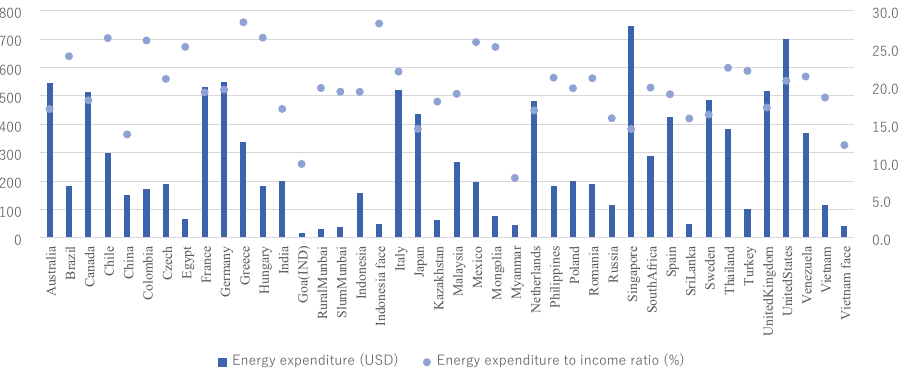
Figure 1. Average monthly energy expenditure at the household level across the 37 surveyed nations. Data source : Original